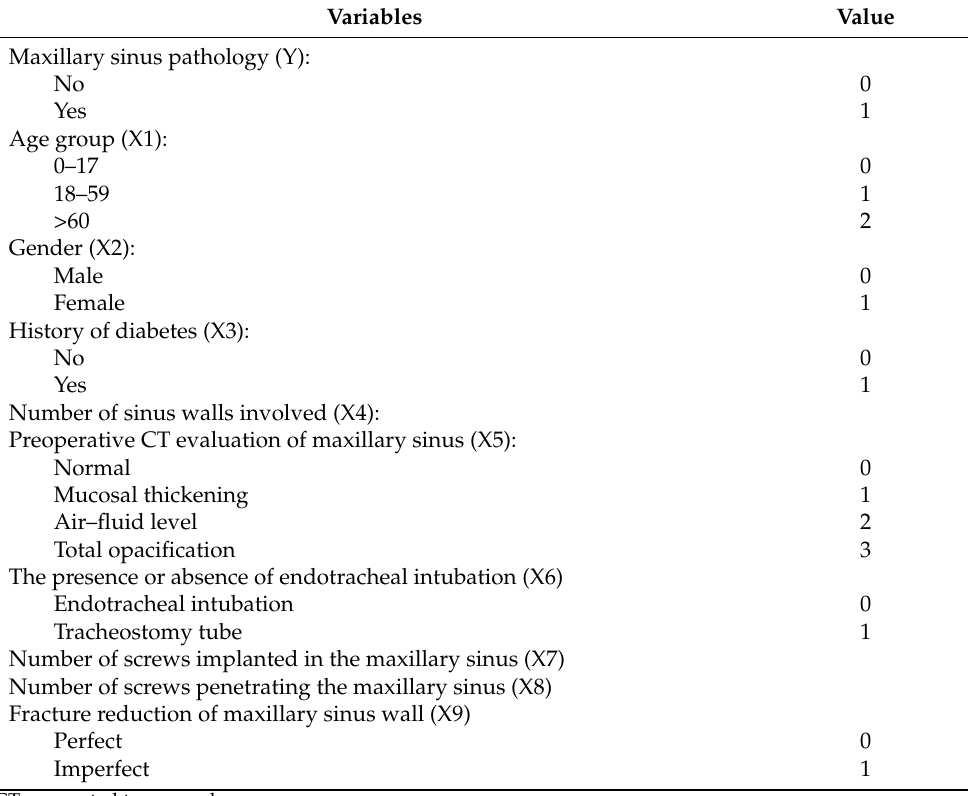
Table 1. Variables and assignment of